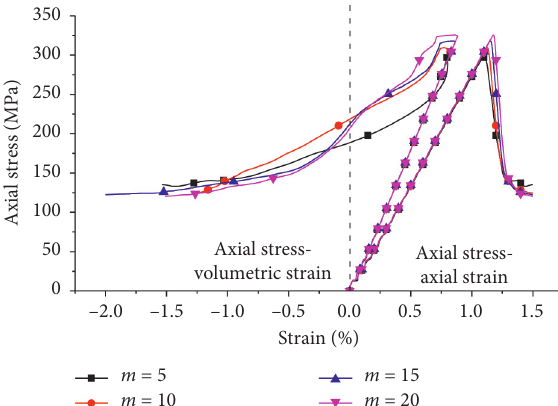
Figure 9: Simulated stress-strain relations for models with different homogeneity m under the confining pressure 20MPa.